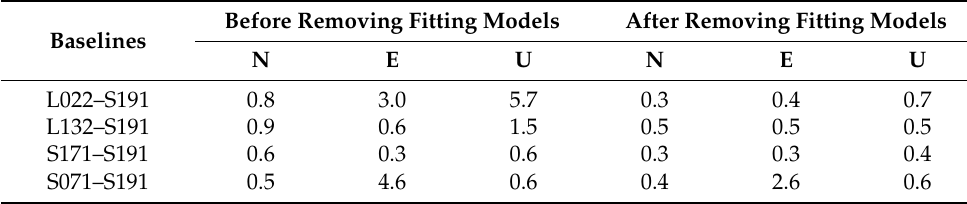
Table 6. Baseline RMS (station-S191)statistics before and after removing the fitting models.